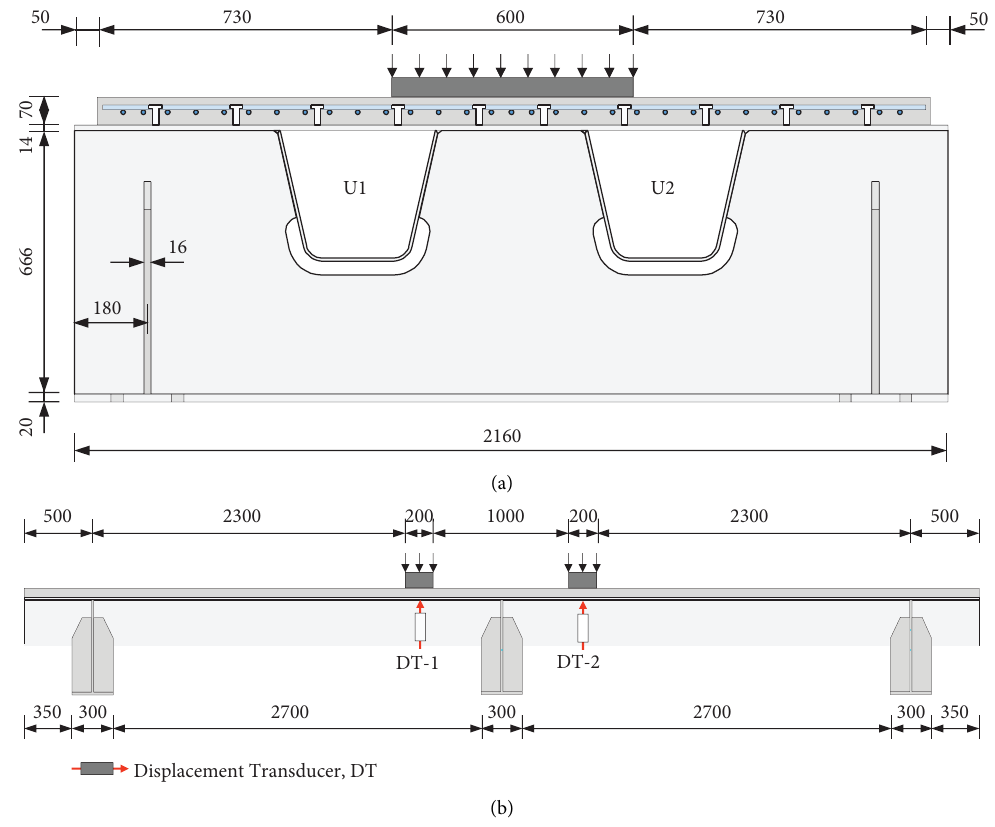
Figure 4: Geometry of longitudinal specimen (unit: mm): (a) cross section view; (b) side view.